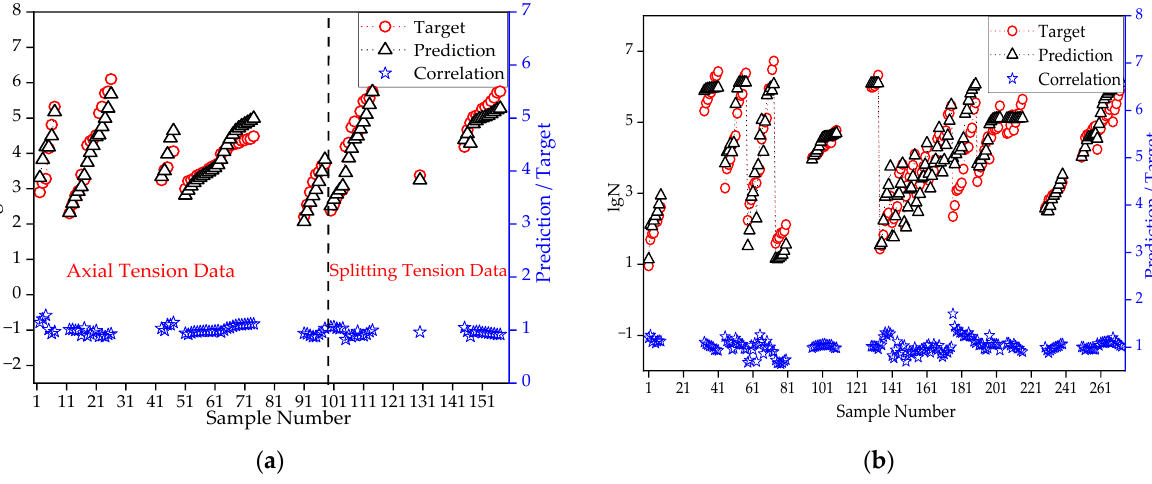
Figure 14. Mutual prediction of flexural and tensile fatigue life using BR-BPNN with data from Reference [43] excluded from analysis: ( a ) Prediction of tensile fatigue based on flexural fatigue network; ( b ) Prediction of flexural fatigue based on tensile fatigue network.